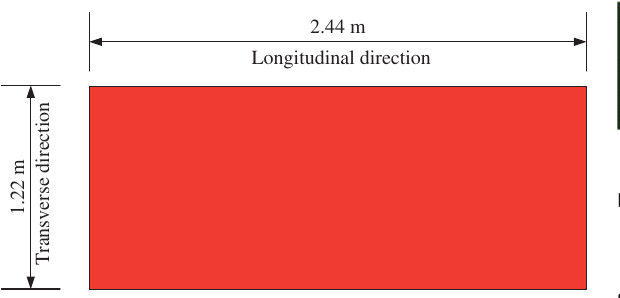
Figure 3: Size of whole bamboo-plywood.